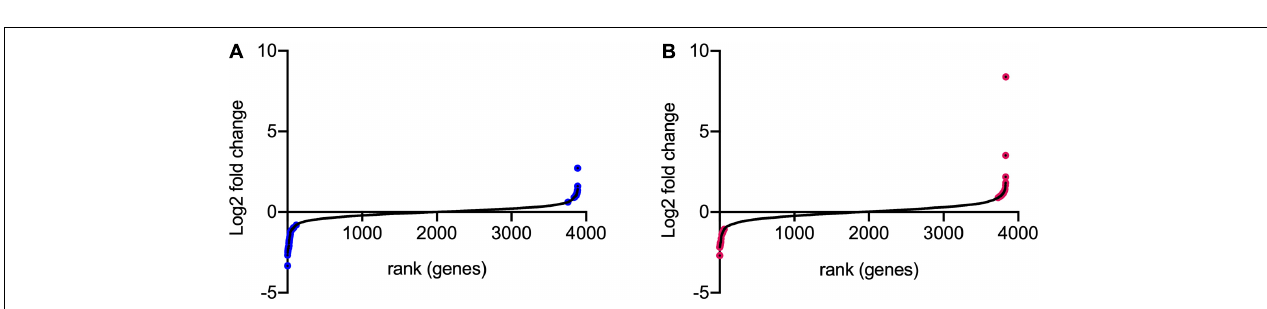
FIGURE 3 | Replicates of TraDIS samples are highly correlated. Gene insertion index scores for all non-essential genes are shown for the two biological replicates of the control (input) transposon library (A) , and after selection in model honey for (B) 30 min (TL30_1, TL30_2) and (C) 90 min (TL90_1, TL90_2), followed by 2 h outgrowth in LB in both cases.